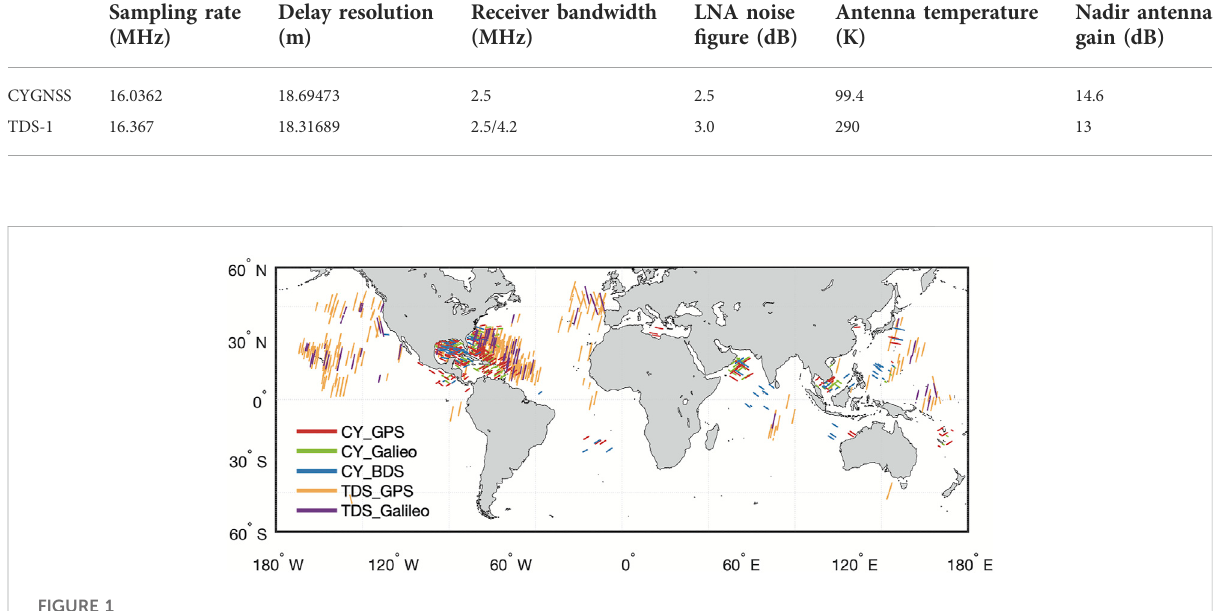
FIGURE 1 Mapofspecularpoint groundtracksoftherawIFdata usedinanalysis,withdifferentcolors indicating datasources.The number ofthetracksis presented in Table 2.